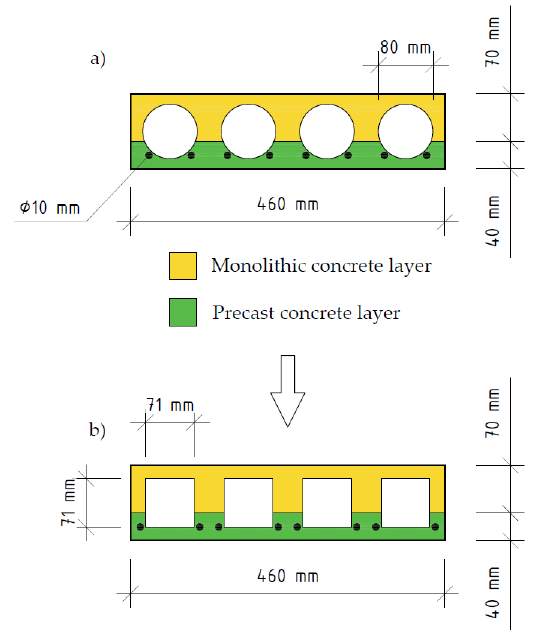
Figure 4. Slab cross section: ( a ) actual cross section; ( b ) transformed cross section.